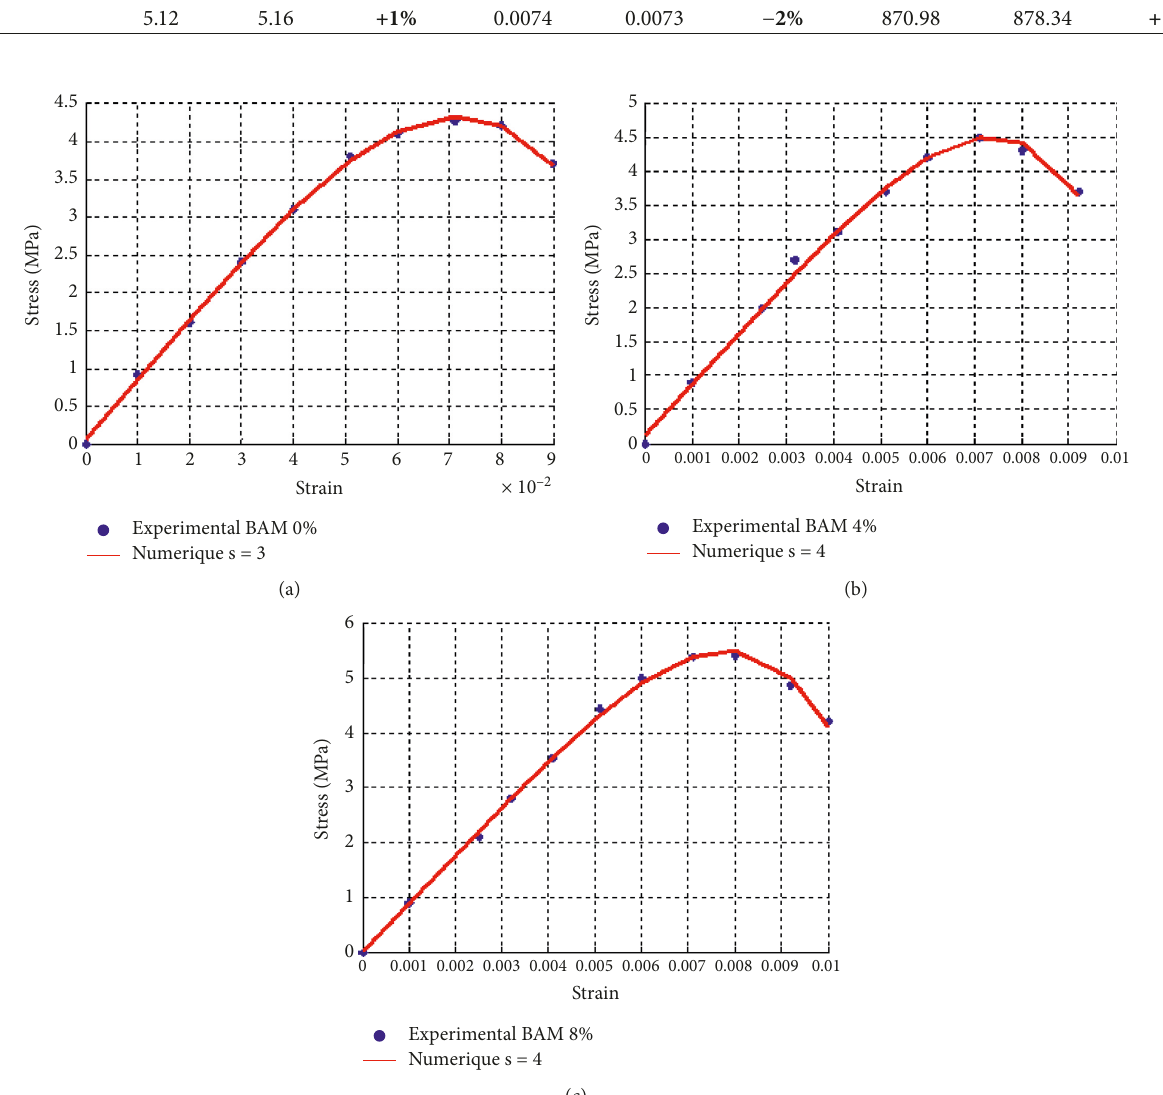
Figure 8: Simple compression stress based on the strain of BAM (0%, 4%, and